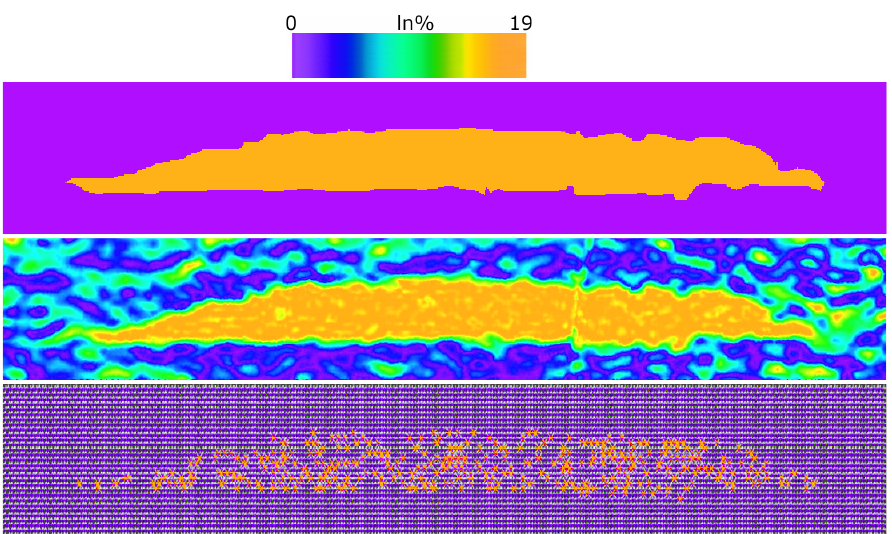
Figure 2. Two-dimensional distributions of the In content in the QD. ( Top ): the structure with a uniform In distribution of (19%). ( Center ): the structure derived by an algorithm accounting for the experimental local In content. ( Bottom ): the structure with an atomistic homogeneous random In distribution in InGaN QD with the mean content of 19% (bigger orange spots correspond to In